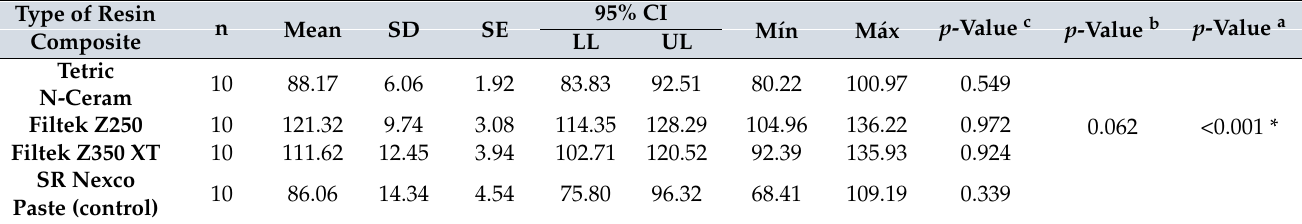
Table 2. Comparison of microflexural strength without additional dry heat curing, according to the type of resin